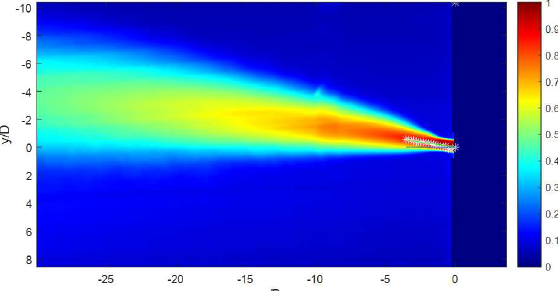
Fig. 7. Mean non-dimensional concentration C/C 0 field ( C 0 is the mean concentration measured at the outlet, i.e. the initial jet concentration) for a jet with r = 0.053 ( θ ≈ 12°); the white asterisks are the concentration maxima in the initial region of the jet, the green line is the jet axis, the blue line is the line perpendicular to the pipe axis.